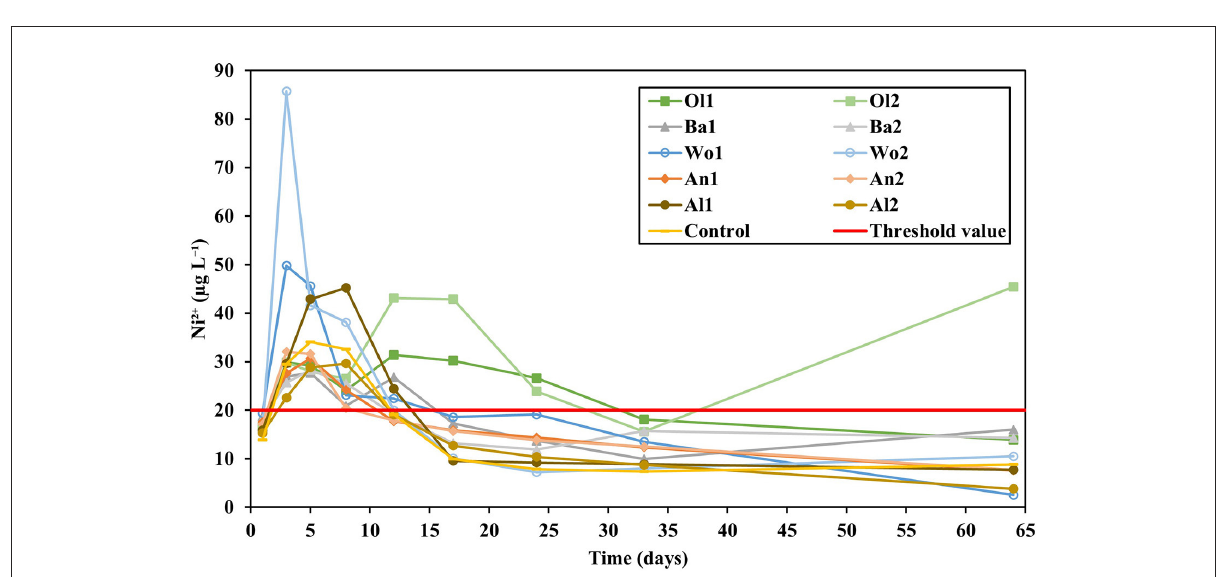
FIGURE6 Ni 2 + concentrations measured in the leachate over time. The red line represents the Dutch threshold value for Ni 2 + concentrations in groundwater (Besluit kwaliteitseisen en monitoring water,